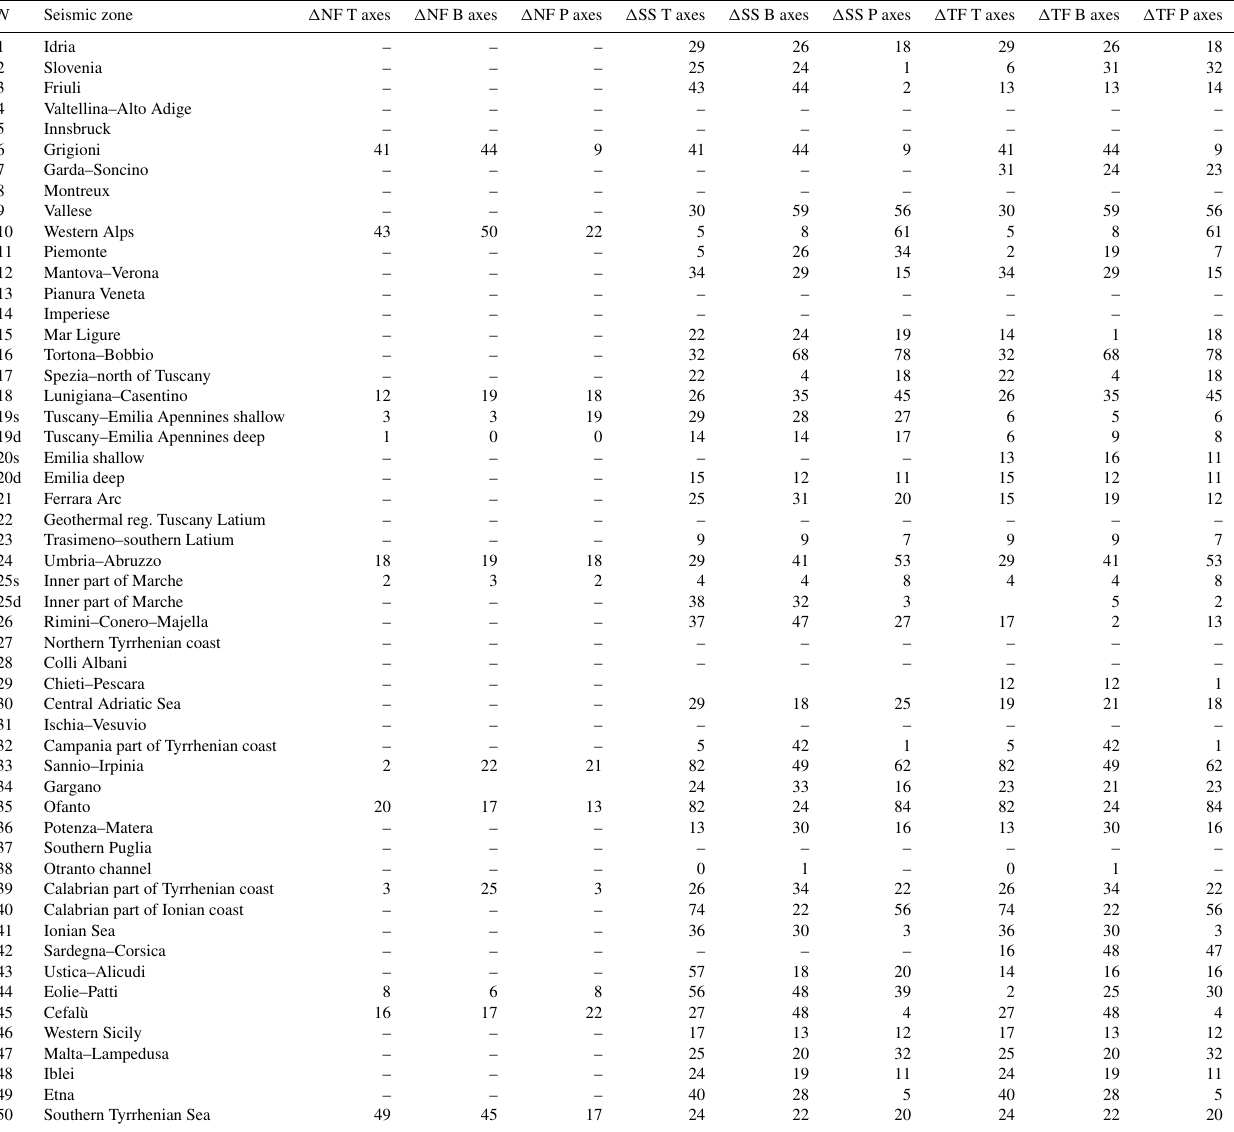
Table 2. Results of the evaluation of P-, T-, and B-axis dispersion. In each column (cid:49) is reported in degrees, i.e., the median of the angular differences between the axes of each single focal mechanism and the axes of the cumulative one (see Fig. 4).